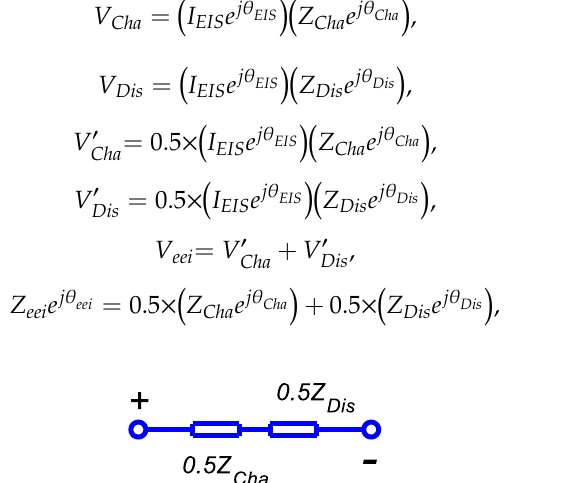
Figure 2. AC equivalent first principle impedances ( Z eei e jθ eei ) on electrode–electrolyte interfaces.